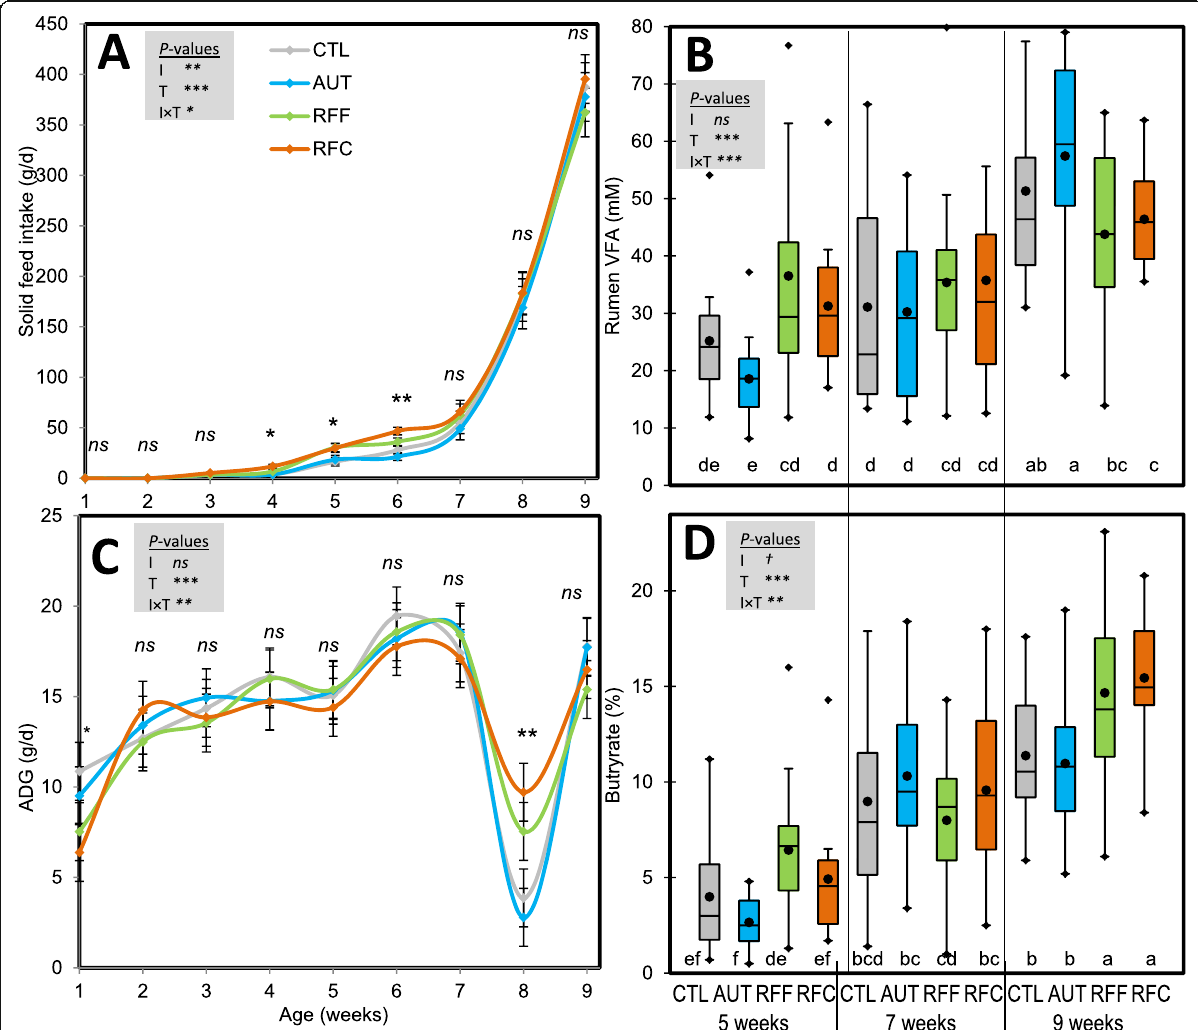
Fig. 1 Effect of early-in-life rumen microbial inoculation on animal performance in goats. A) feed intake, B), rumen total VFA, C) animal growth and D) rumen butyrate molar proportion. Goat kids were inoculated (I) with fresh rumen fluid from adult goats adapted to forage-rich (RFF) or concentrate-rich diets (RFC), autoclaved rumen fluid (AUT) or absence of inoculation as control (CTL) and sampled at different times (T). In Figs. B and D, treatment means with different letters